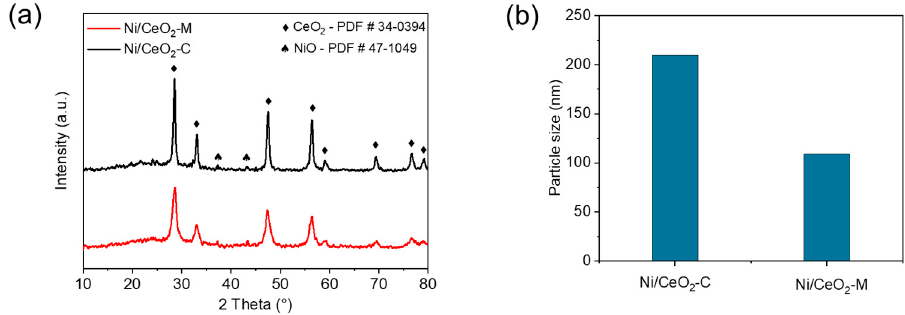
Figure 1. ( a ) XRD patterns and ( b ) particle size of Ni/CeO 2 -C and Ni/CeO 2 -M catalysts. Table 1. Characteristics of Ni/CeO 2 -C and Ni/CeO 2 -M catalysts.